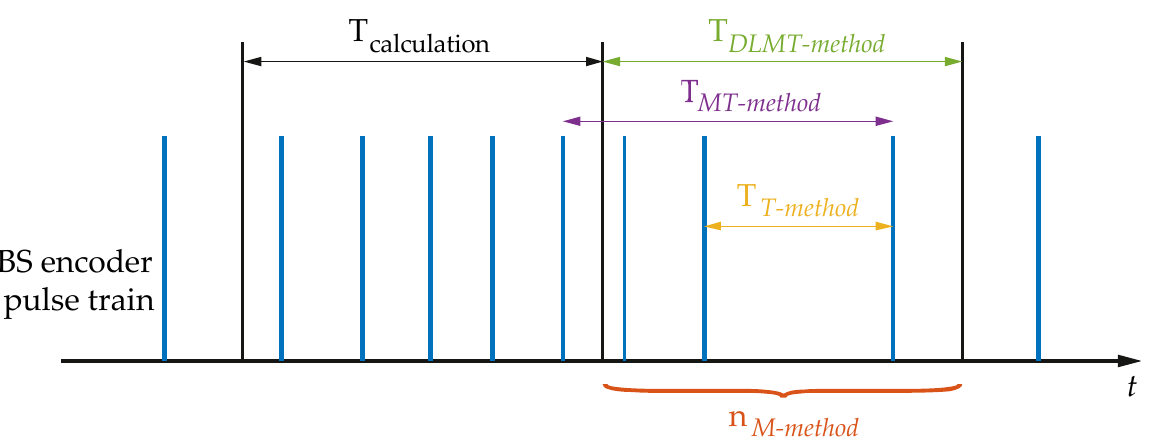
Figure 5. Measured variables for the four different methods mentioned.